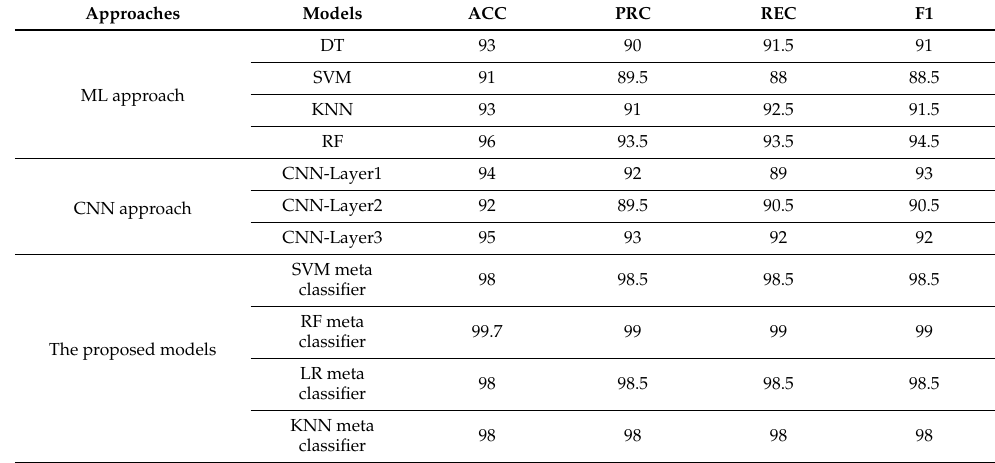
Table 8. The average ACC, PRC, REC, and F1 when applying the models to the PTB dataset. Approaches